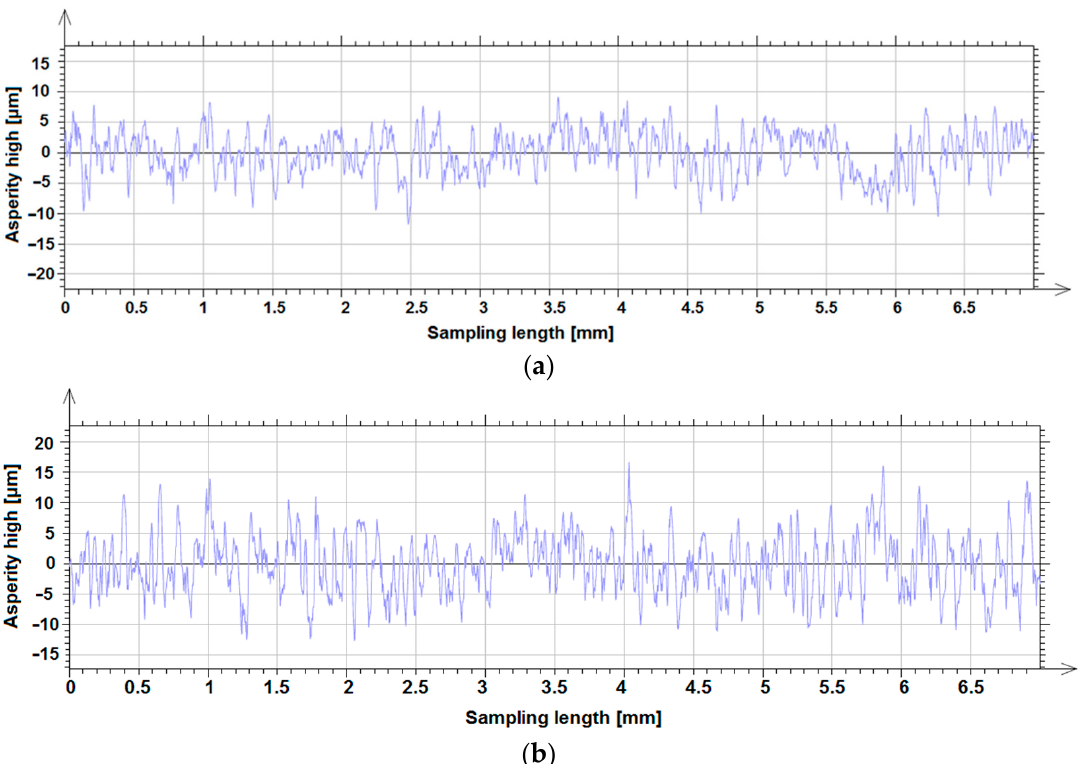
Figure 8. Roughness profile recorded for the CaP coating deposited on the CpTi G4 substrate from the acetate bath at − 3 V for 30 min at: ( a ) 20 °C; ( b ) 70 °C. Table 2. Basic surface texture parameters with standard deviations ( SD ) for the CaP coatings deposited on the CpTi G4 substrate from the acetic bath at − 3 V for 30 min at the bath temperature of 20–70 °C, according to ISO 4287 [45].